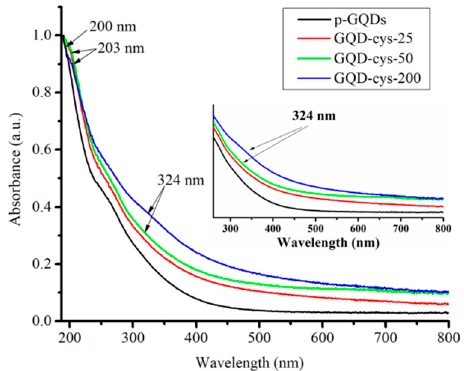
Figure 1. UV–Vis spectra of p-GQDs (black), GQD-cys-25 (red), GQD-cys-50 (green), GQD-cys-200 (blue).